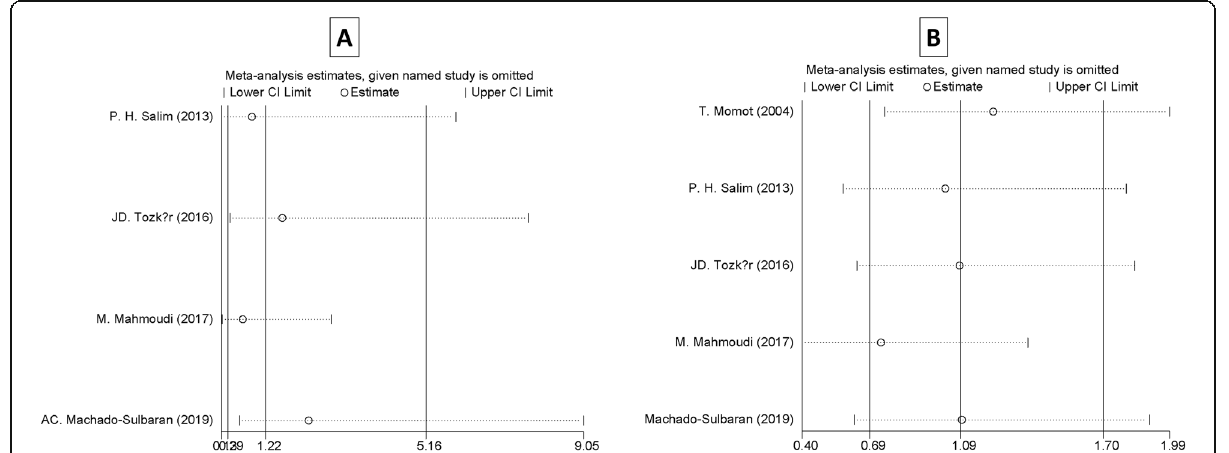
Fig. 3 Influence plot. The graph presents sensitivity analysis for ( a ) 2DP1 and ( b ) 3DL1